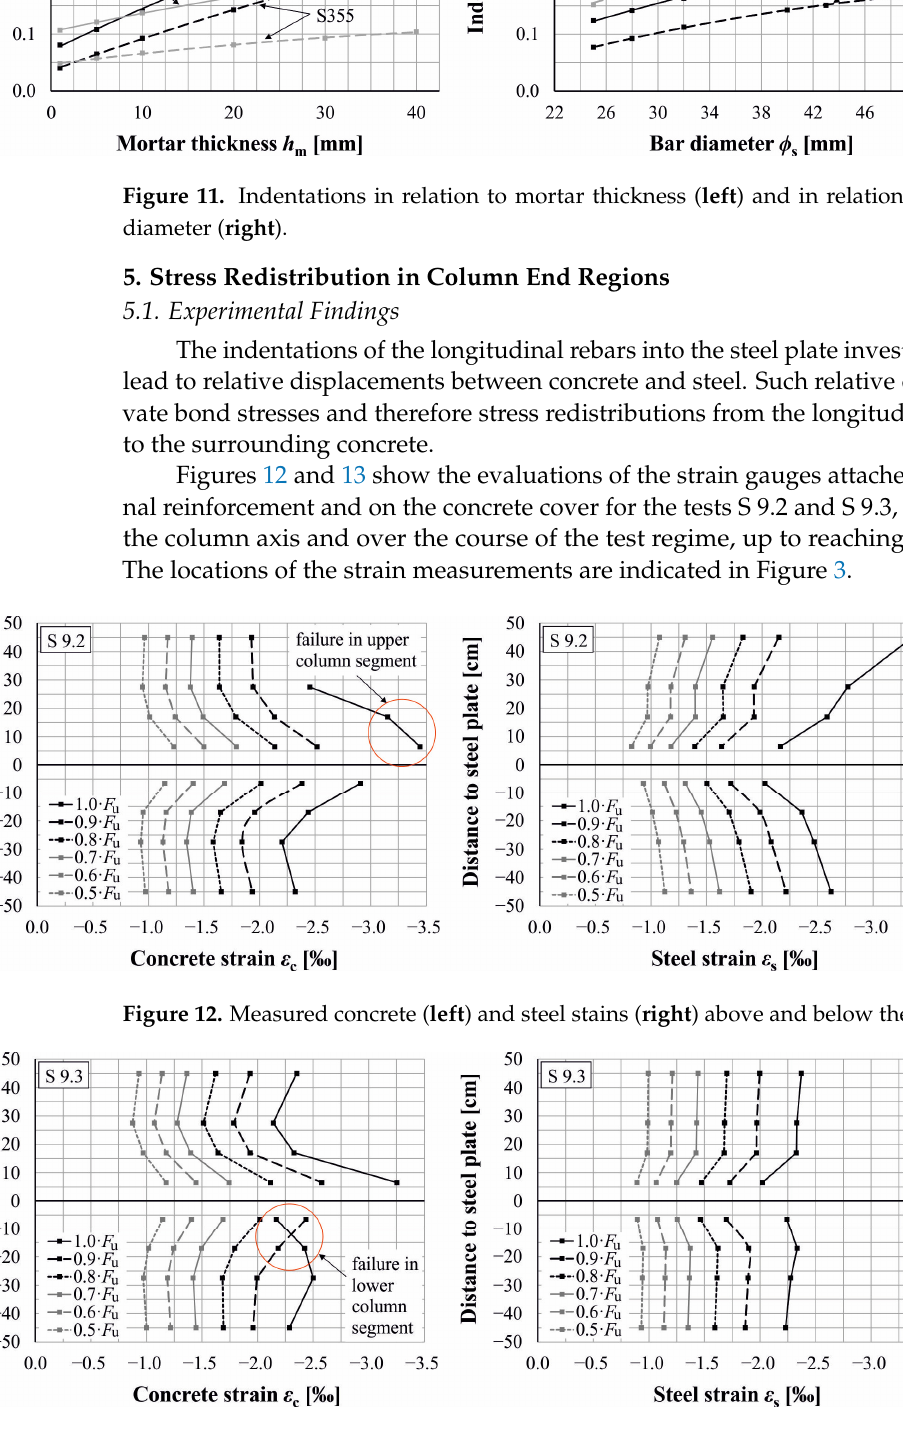
Figure 13. Measured concrete ( left ) and steel stains ( right ) above and below the butt joint for S 9.3.